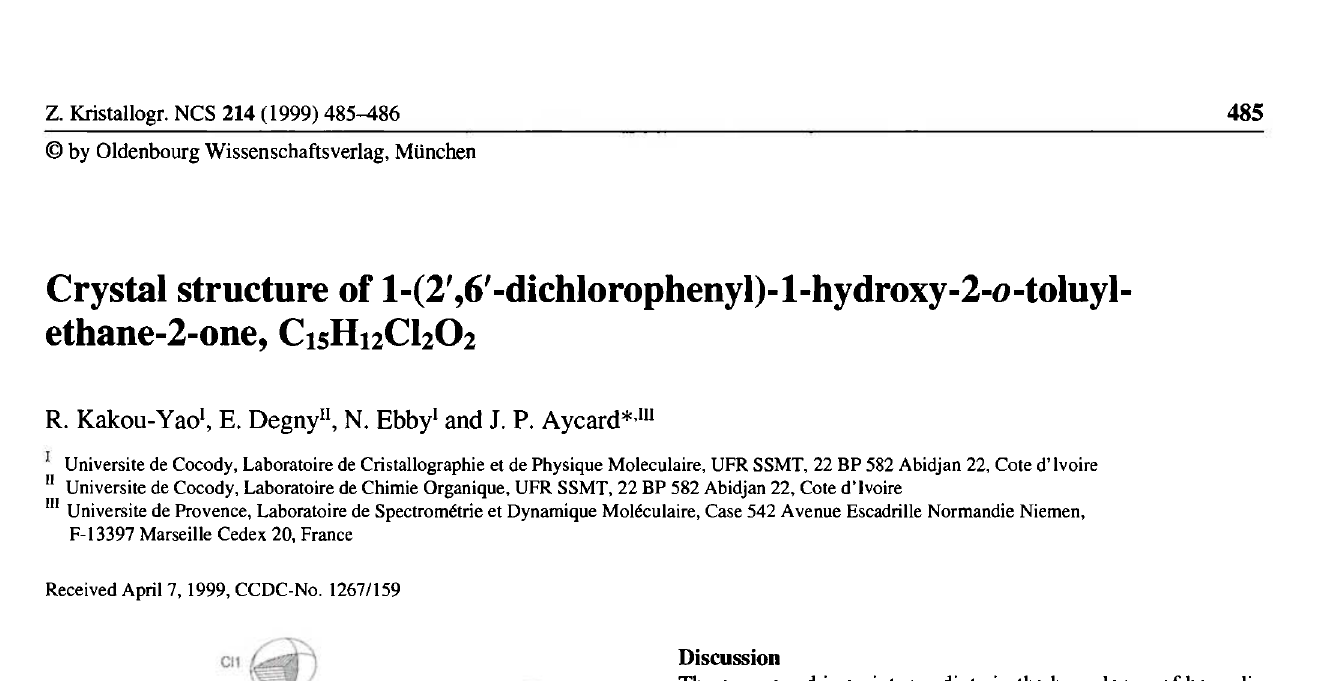
Table 1. Data collection and handling.